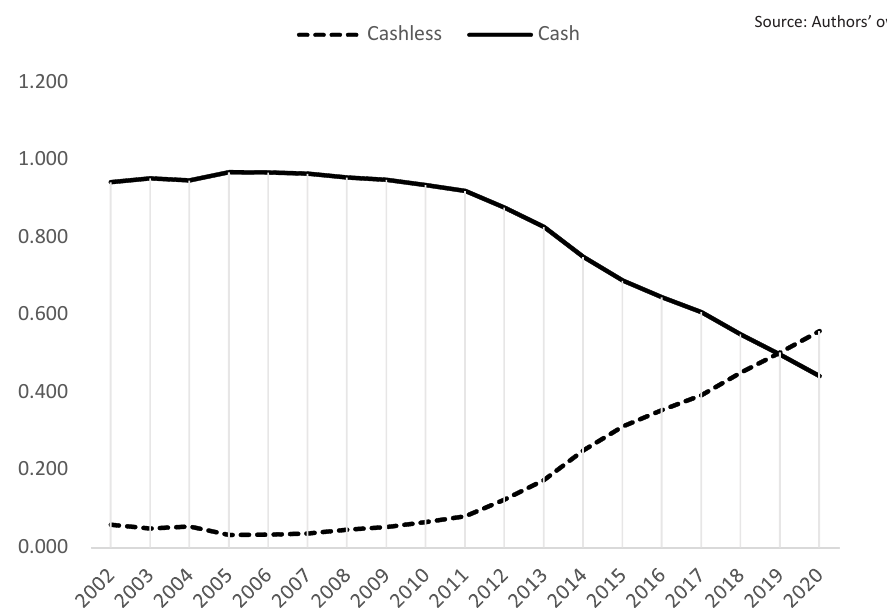
Figure 2. Share of non-cash payment and cash withdrawal transactions in the total volume